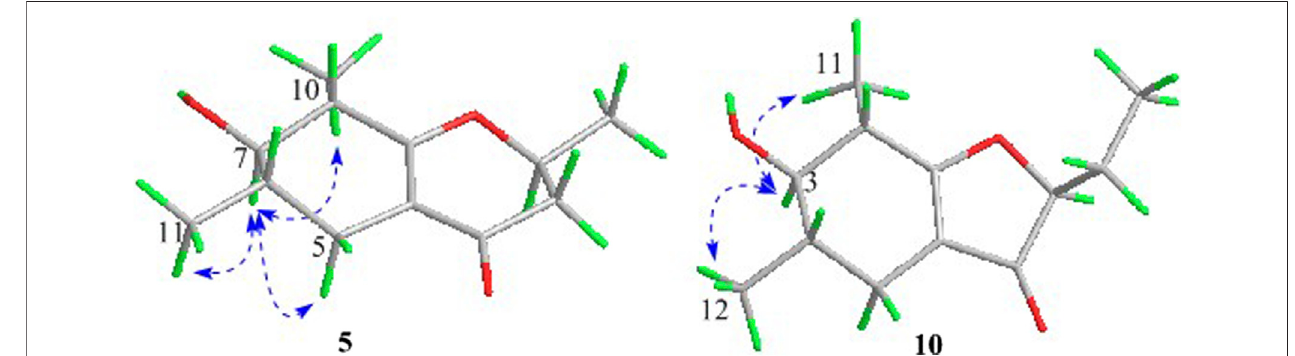
FIGURE 7 | Key NOESY correlations of compounds 5 and 10.